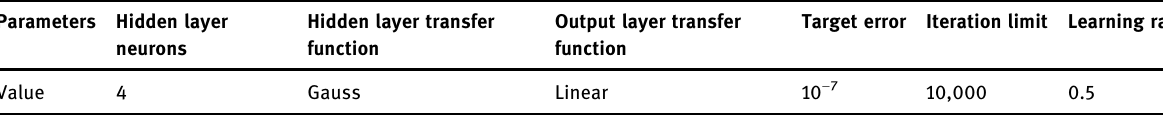
Table 3: RBF neural network parameters